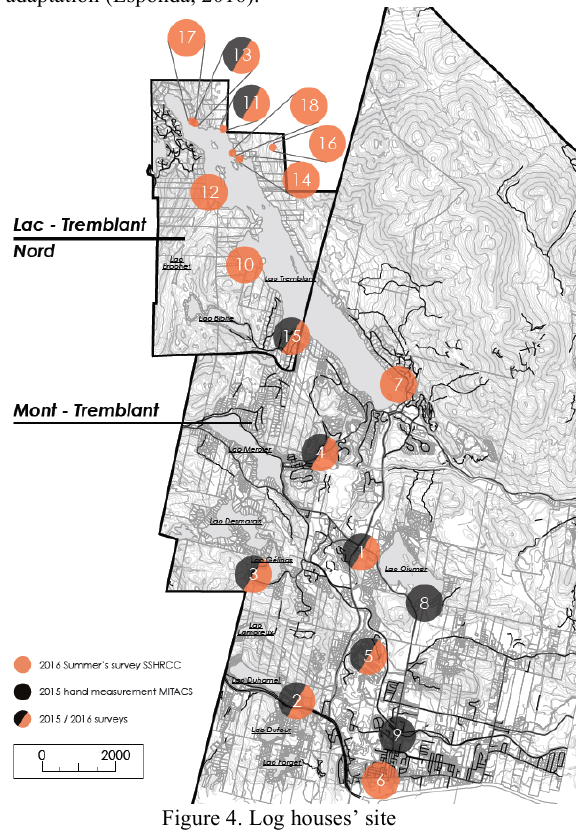
Figure 4. Log houses’